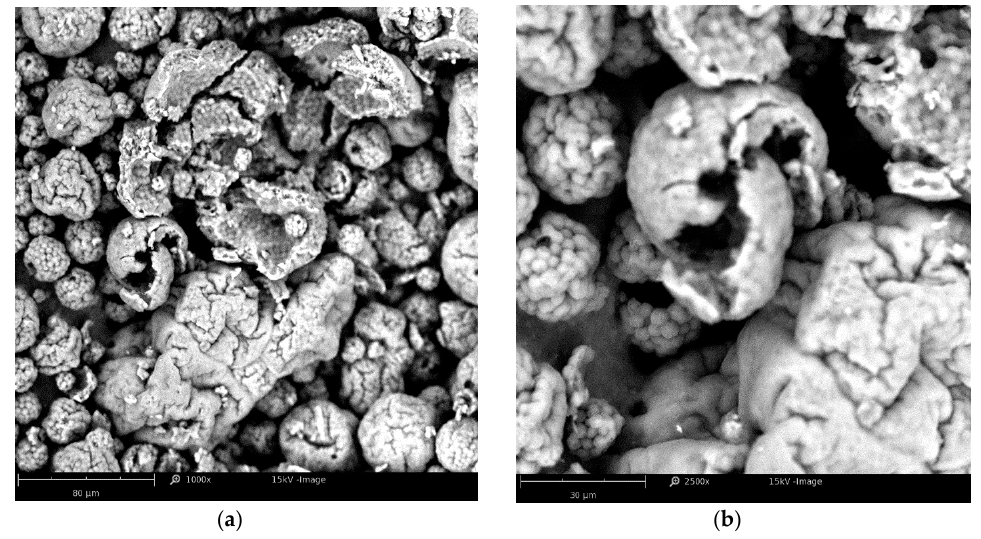
Figure A3. SEM image of dried Spirulina SP. after Soxhlet extraction by hexane at ( a ) 1000 × magnification, 15 kV; ( b ) 2500 × magnification 15